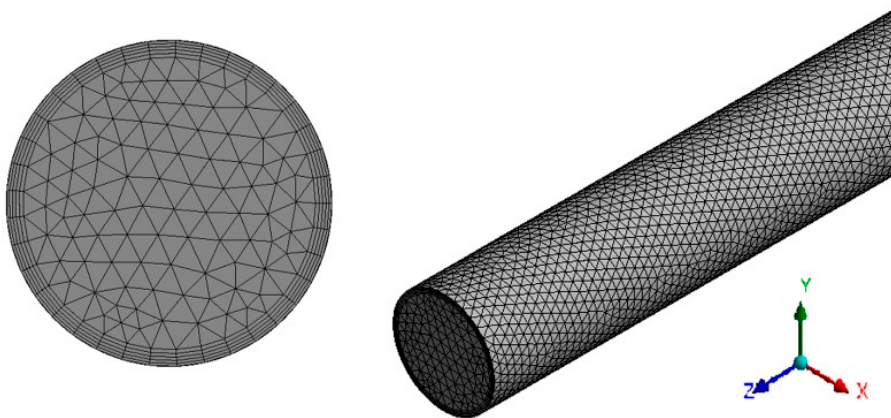
Figure 4. Mesh model for straight pipes.